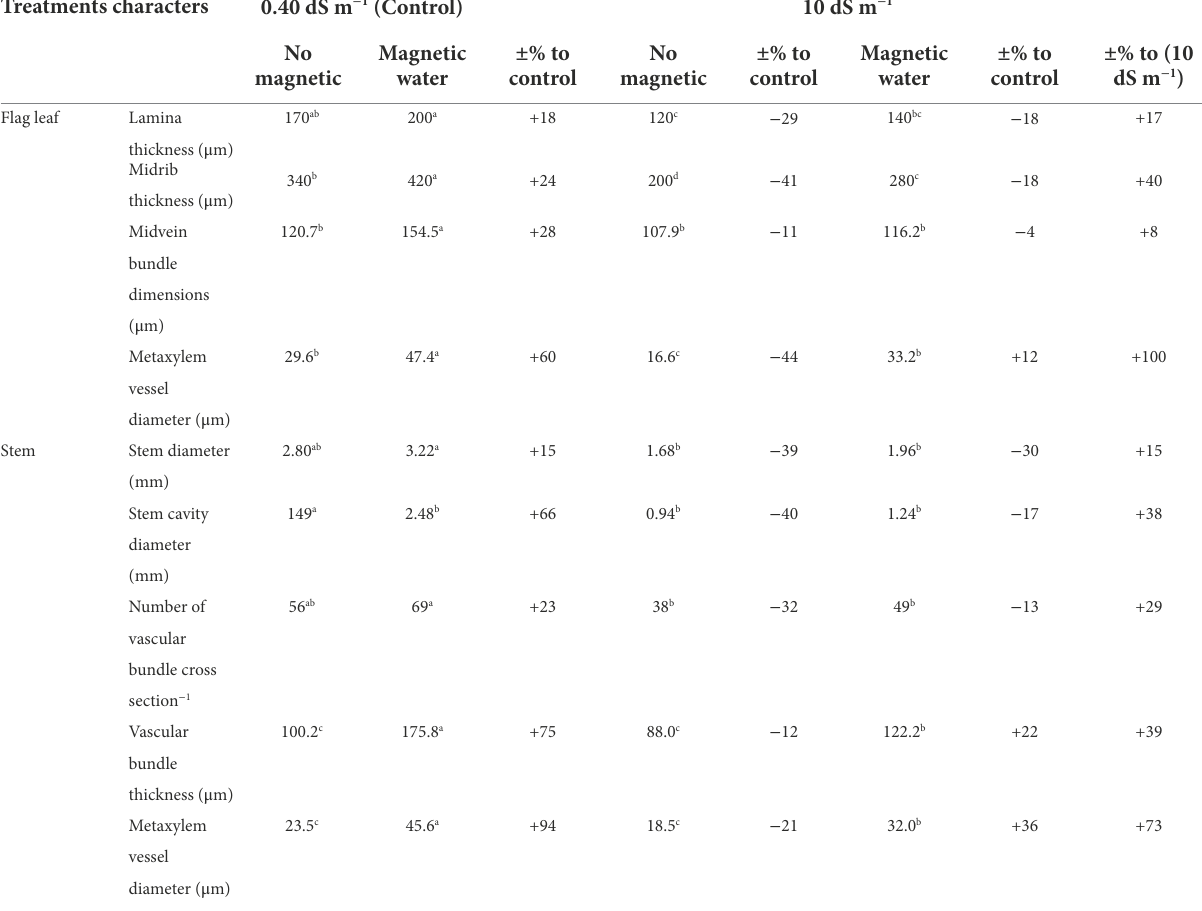
TABLE 8 Effect of seawater stress levels, magnetic treatment on some anatomical parameters in flag leaf and stem of wheat plants during the second growing season. Treatments